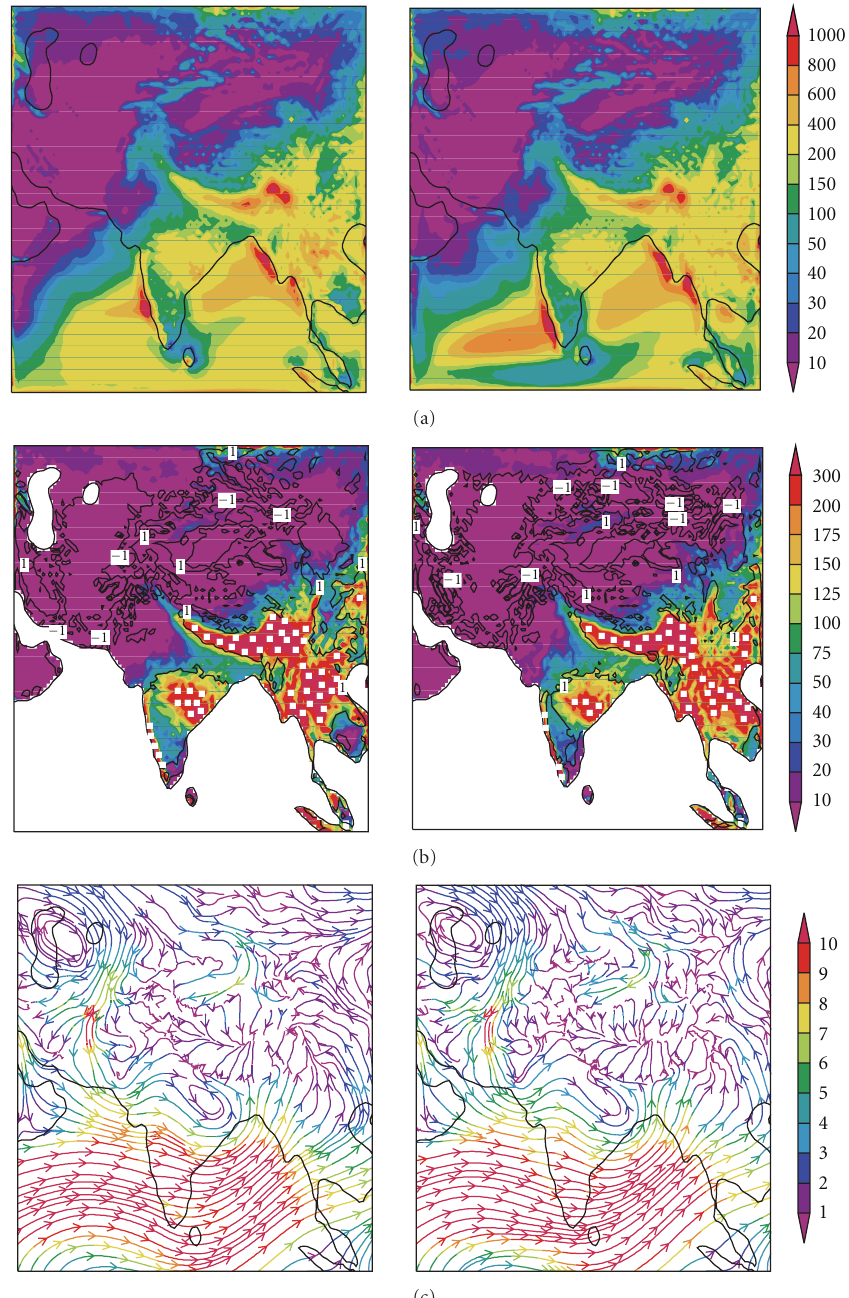
Figure 14: Precipitation (mm; shaded) (a), Precipitation-Evaporation (mm; shaded) and vertical velocity at 500 hPa (hPa/h; contour lines) (b), mean wind fields (wind vectors) and wind speed at 850hPa (m/s; colours) (c) for HIRHAM “BOUND20” (left) and HIRHAM “BOUND10” (right); summer monsoon (JJAS) 1990–2000. White dots in (b) show areas with positive anomalies in both P-E and ω .